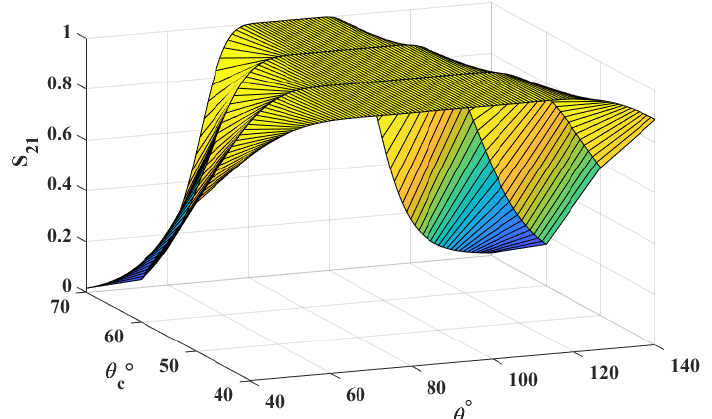
Figure 4. Transfer characteristics of Chebyshev Bandpass